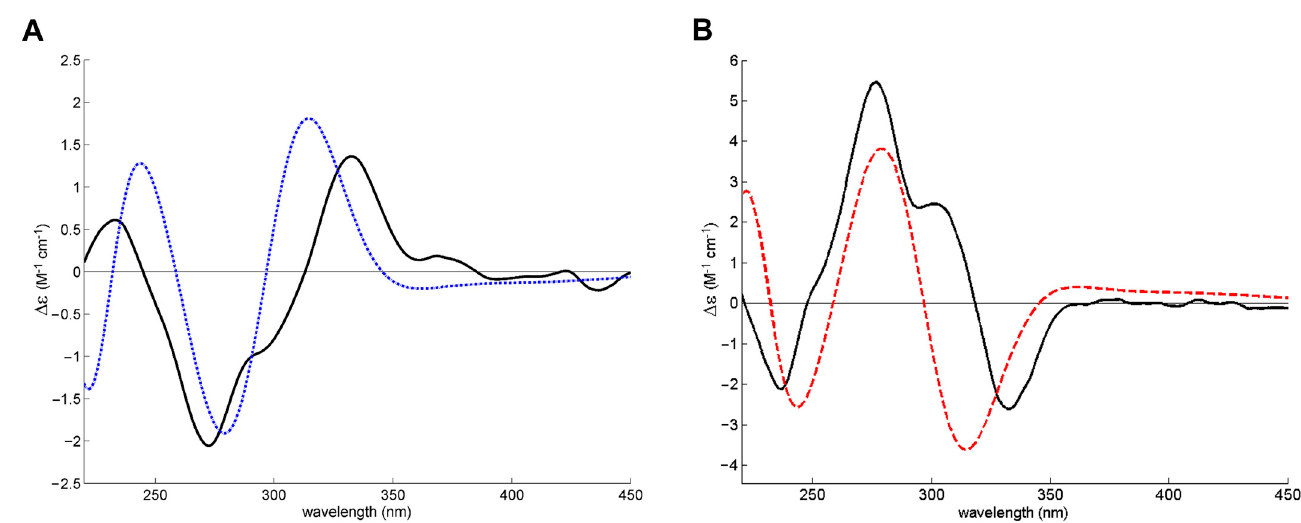
Figure 5. Experimental methanol ECD spectrum of the enantiomeric fractions (solid black line) of E1 ( A ) and E2 ( B ) superimposed with the theoretical ECD spectrum of S -MDPV (dashed blue line) and R -MDPV (dashed red line) computational models.